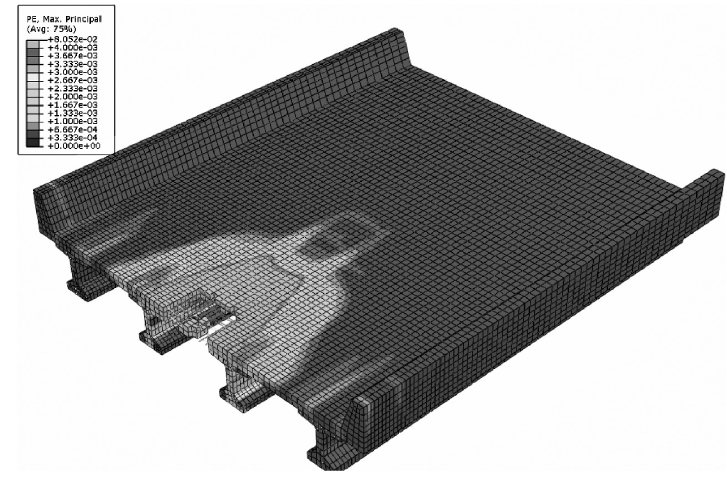
Fig. 19. Maximum principal plastic strain, blast above, between girders. Top view.